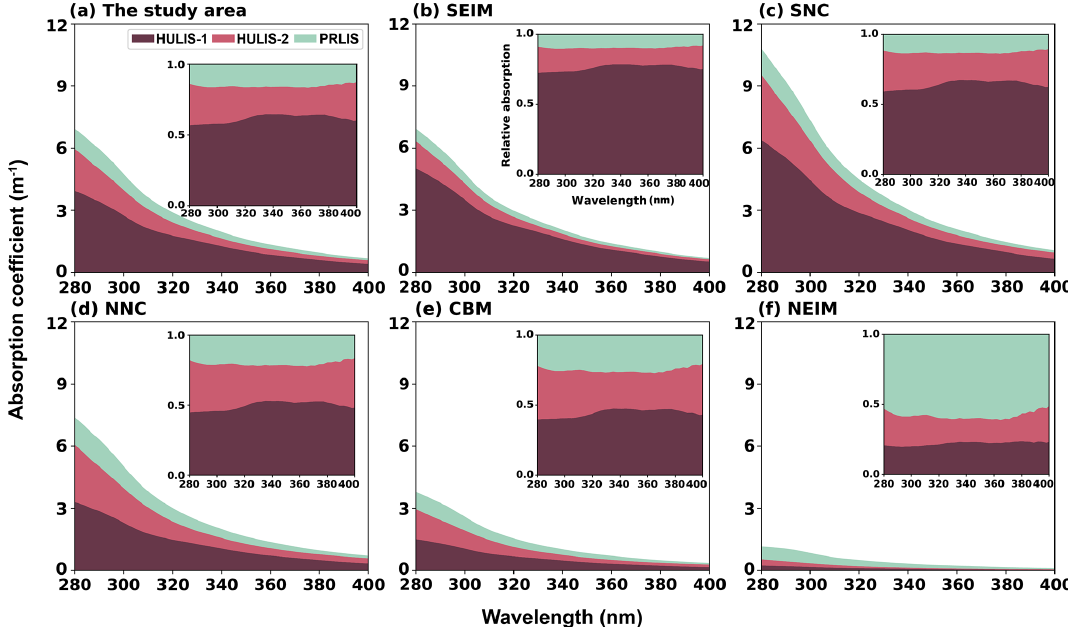
Figure 6. Relative contributions of the three components to the total absorption of samples in (a) the whole study area and (b–f) each of the five